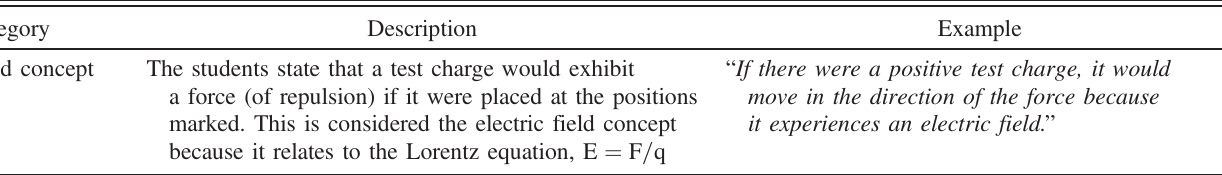
TABLE III. We present the categories of explanation in the first question of the electric context.